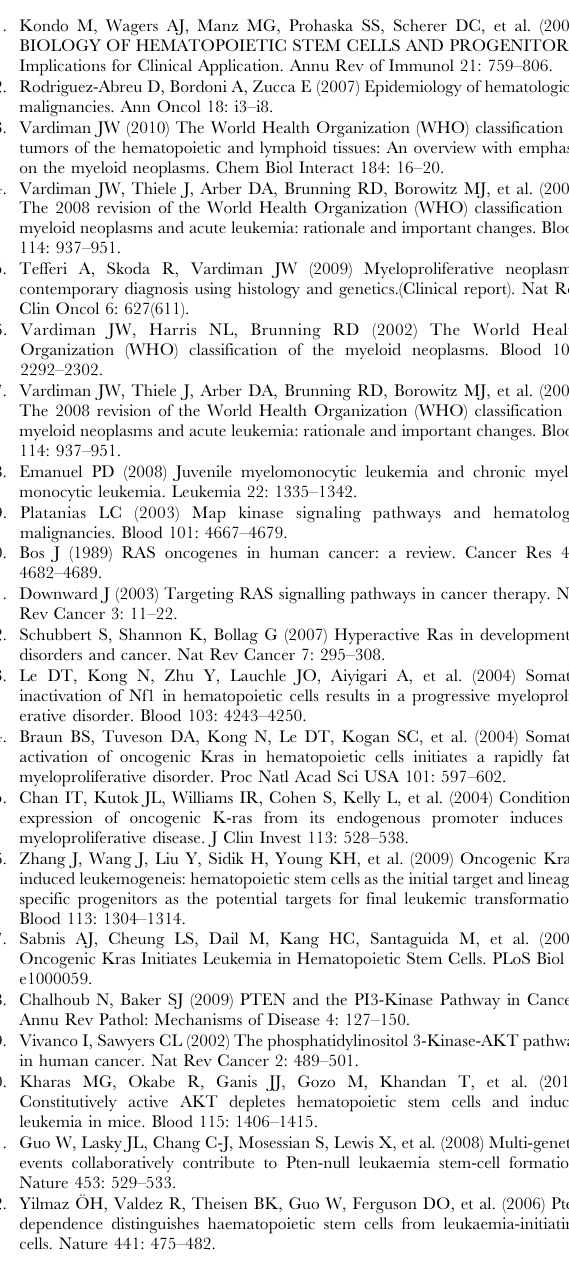
Figure S2 Expression of active MEK in HSCs does not enhance self-renewal. (A–C) HSCs were transduced with retrovirus expressing vector control (black bars) or active MEK (white bars). Following transduction, GFP + cells were sorted, 500 cells/well were plated on methylcellulose media, and colonies were enumerated 5–8 days later. The total colony number is shown in (A). Shape of the representative colony is shown in (B). The avarage number of colony forming cells is shown in (C). (D) The total number of colonies in the secondary culture of colony forming cells in (A–C). NS, P . 0.05 (statistical significance) by Student t test. Figure S3 Active MEK does not enhance cell survival in HSCs. Active MEK + and control HSCs were cultured in IMDM